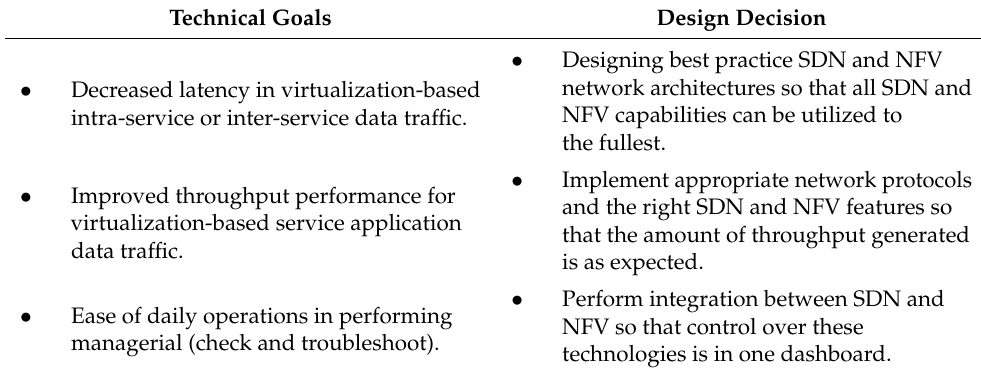
Table 3. Design Decision to Technical Goals Mapping.